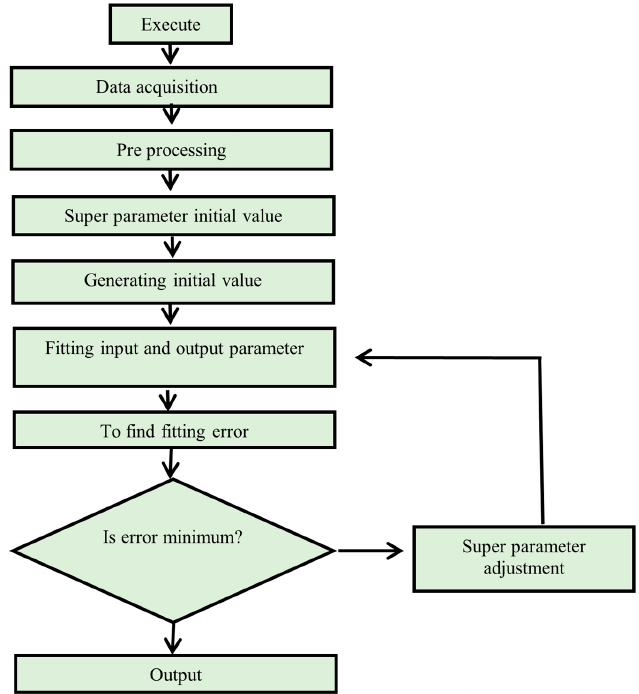
Figure 8. Flow chart of support vector machine.